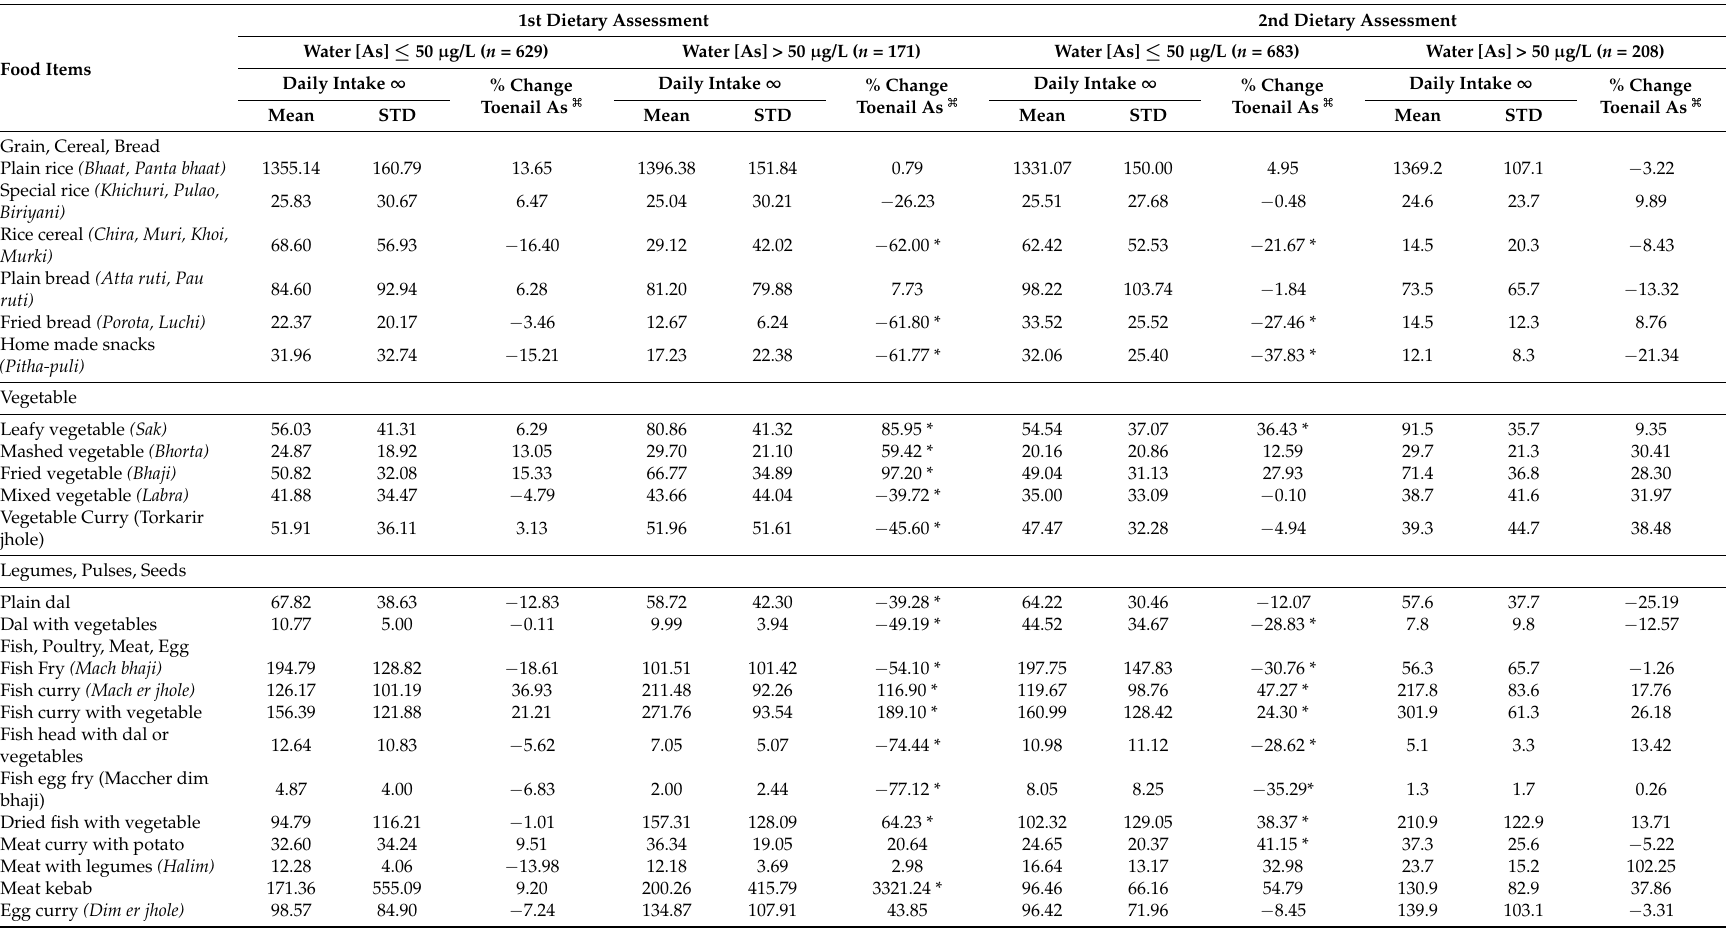
Table 2. Mean daily intake level for each food item and the percent change in toenail As concentration comparing the 5th to the 95th percentile of intake level. Food Items 1st Dietary